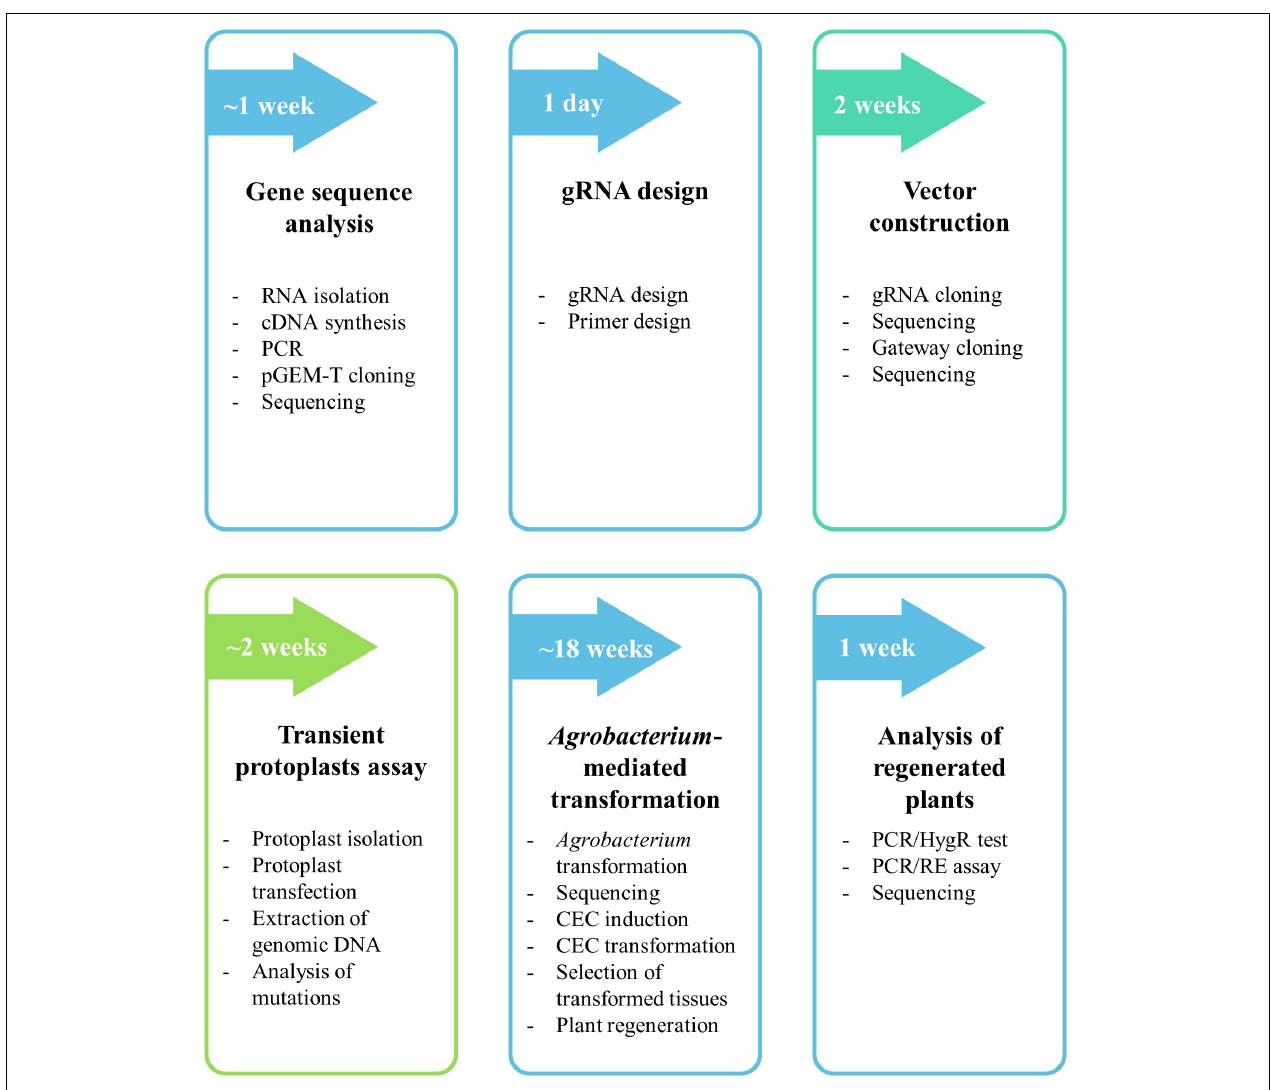
FIGURE 1 | Flow chart of the protocol for targeted mutagenesis of Brachypodium species. The detailed procedure is found in the section “MATERIALS AND